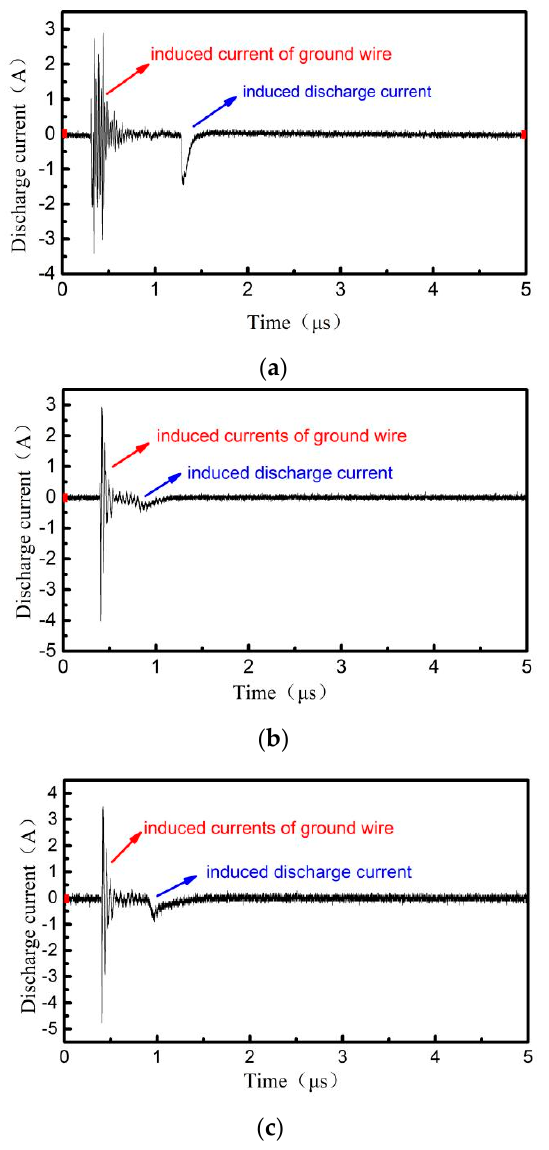
Figure 6. Typical induced discharge waveforms of 3 kinds of dielectric materials under ESD radia- tion, ( a ) PTFE, ( b ) PI, ( c ) EP. ( a ) PTFE, ( b ) PI, ( c )